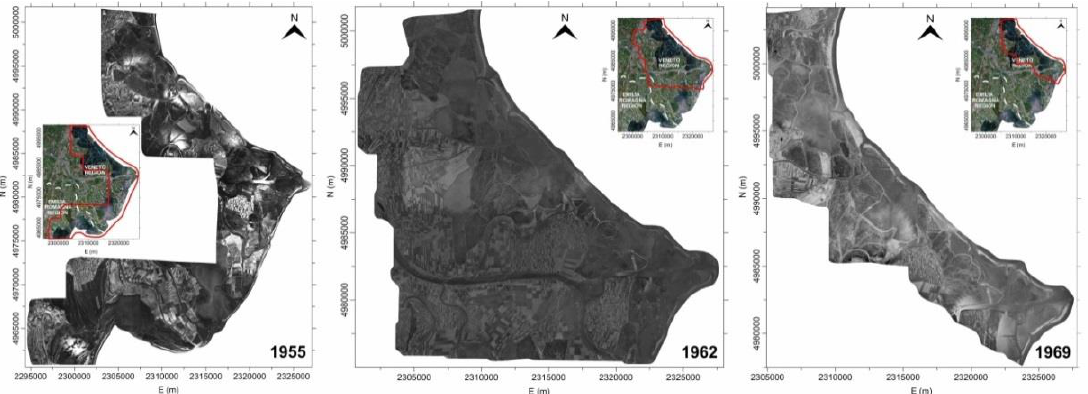
Figure 6. Orthophotos of the 1955 , 1962 , and 1969 aerial photogrammetric surveys: coverage in the PRD coastal area is complete for the 1955 one and restricted in the northern portion both for the 1962 and the 1969 data.